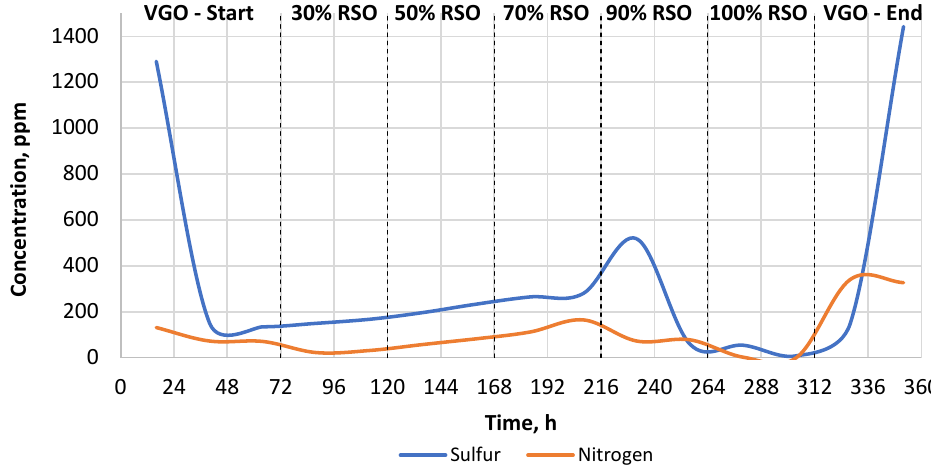
Figure 4. The change in the heteroatom content (S, N) in the liquid products throughout the experiment carried out using the NiW/A-Ph catalyst.